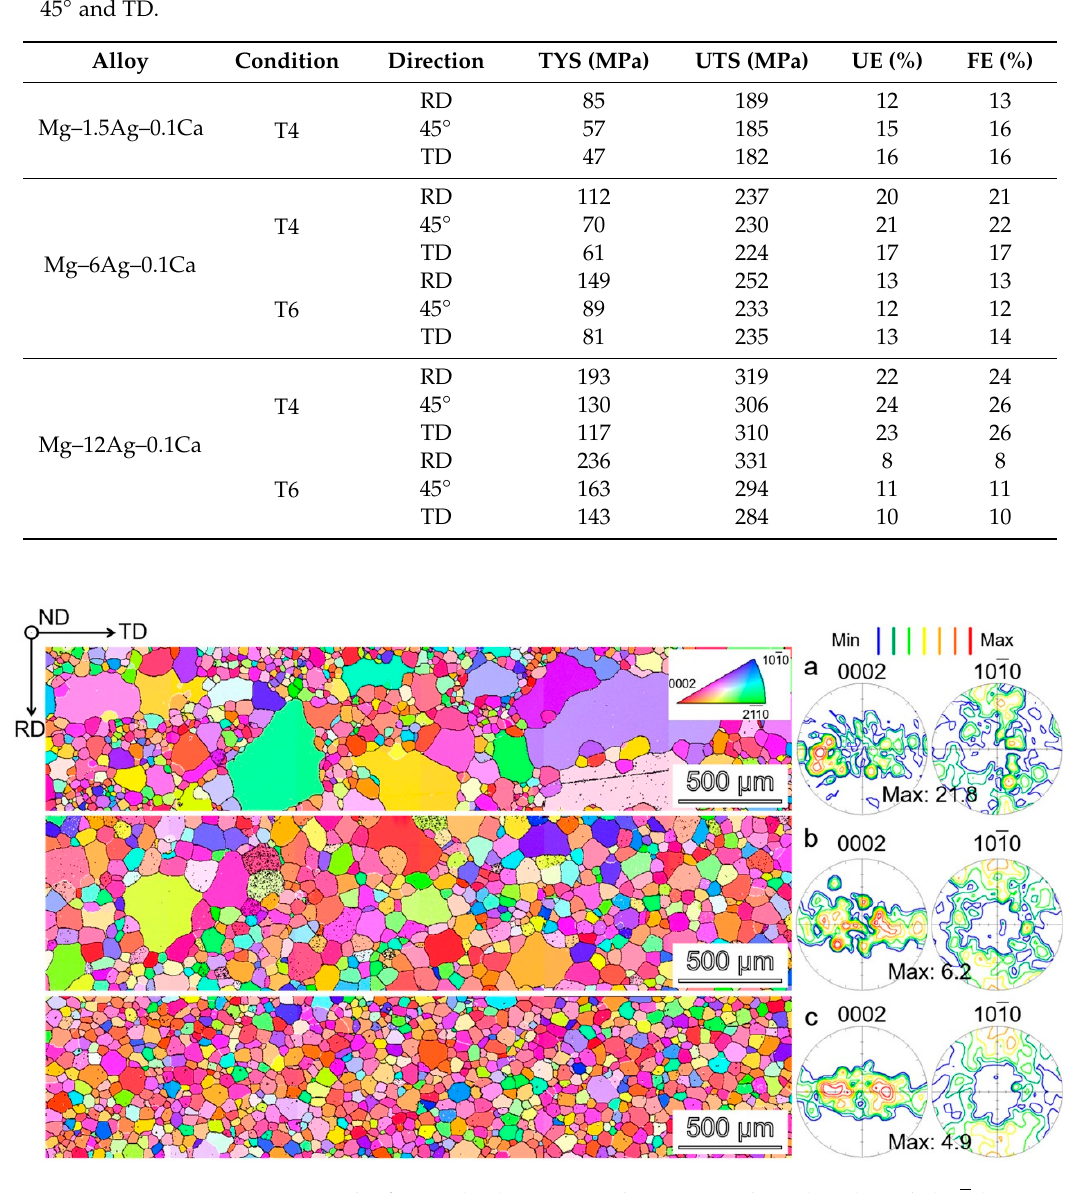
Figure 5. EBSD inverse pole figure (IPF) maps and corresponding (0002) and (101 (cid:3364) 0) PFs showing microstructures and textures of T4 ‐ treated ( a ) Mg–1.5Ag–0.1Ca, ( b ) Mg–6Ag–0.1Ca, and ( c ) Mg–12Ag–0.1Ca alloy sheets.